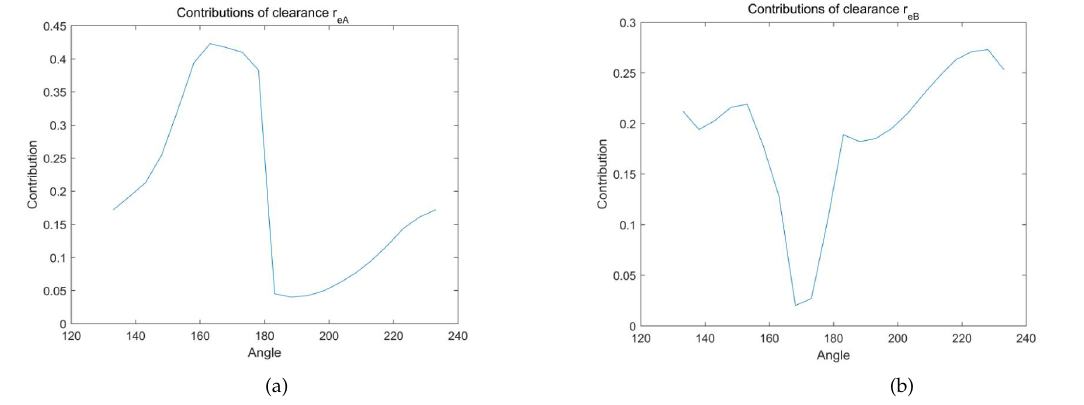
Figure 6. ( a ) The contributions of r eA ; ( b ) The contributions of r eB .